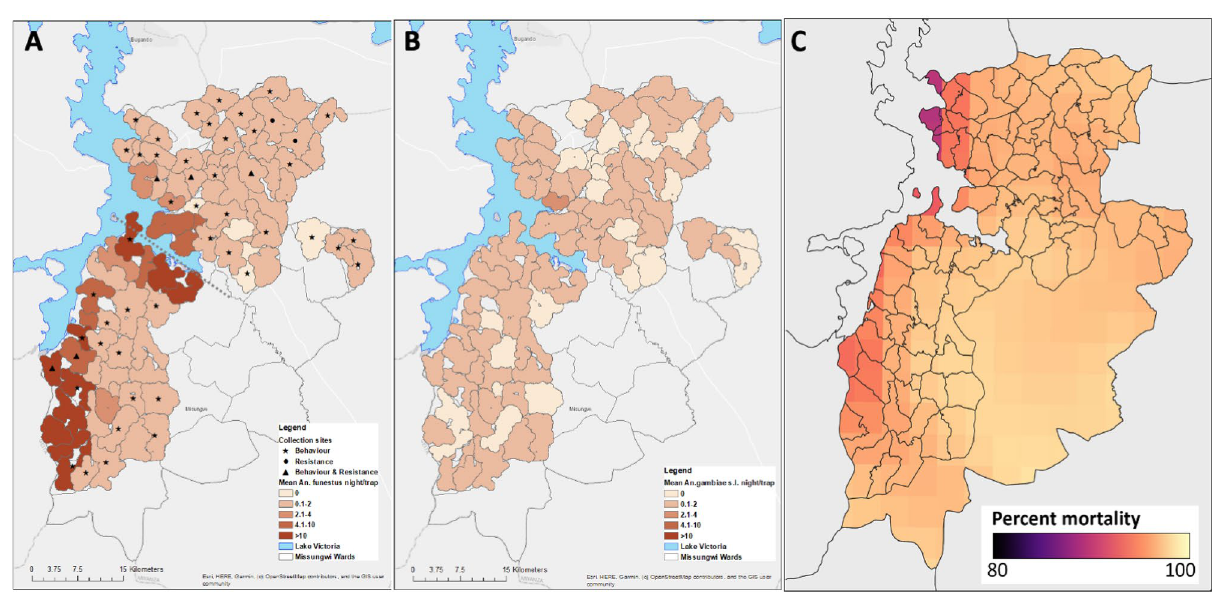
Figure 2. Study area in Misungwi district, North-West Tanzania, displaying ( A ) distribution of Anopheles funestus s.l. and collection methods per cluster (hashed line indicates delineation between northern and southern clusters); ( B ) distribution of Anopheles gambiae s.l.; and ( C ) predicted alpha-cypermethrin resistance for An. gambiae s.l. (mean percentage mortality). The figure was created using ArcGIS 10.8.1